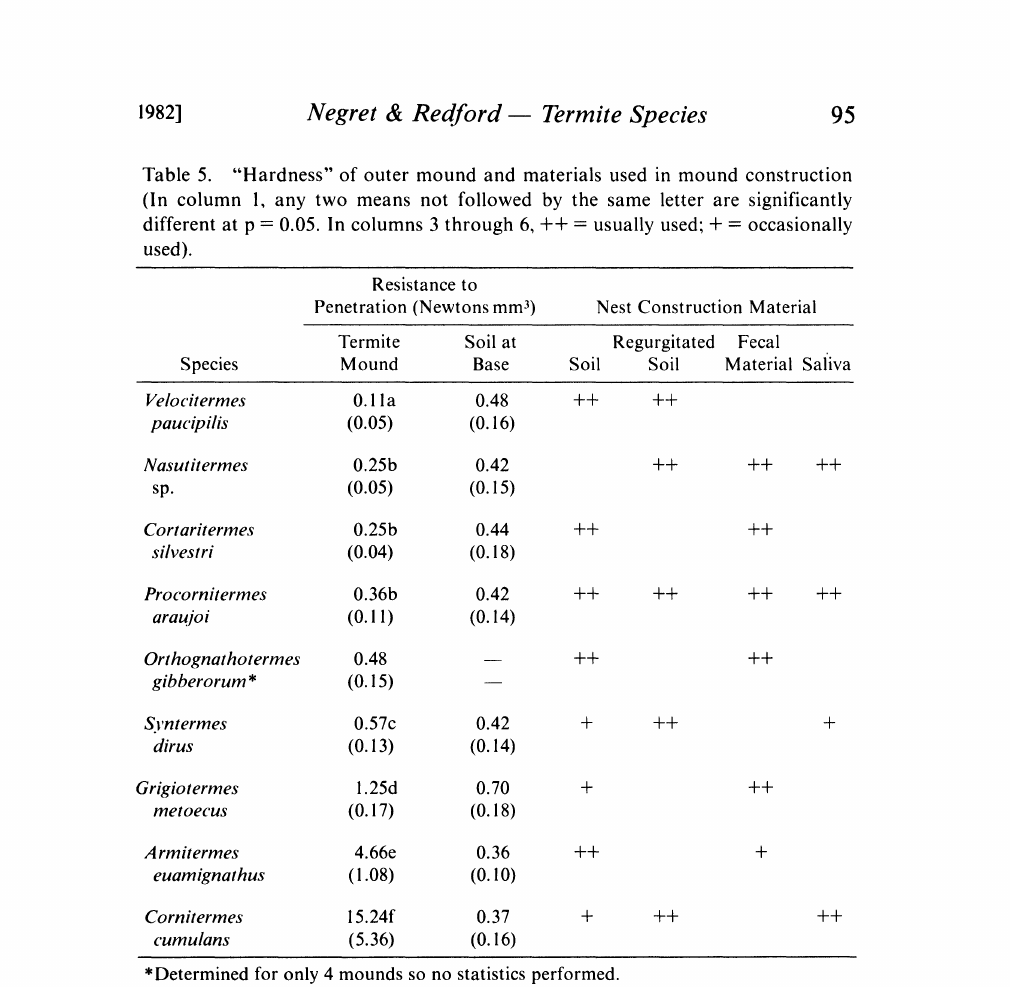
Table 5. "Hardness" of outer mound and materials used in mound construction (In column 1, any two means not followed by the same letter are significantly different at p 0.05. In columns 3 through 6, ++ usually used; + occasionally